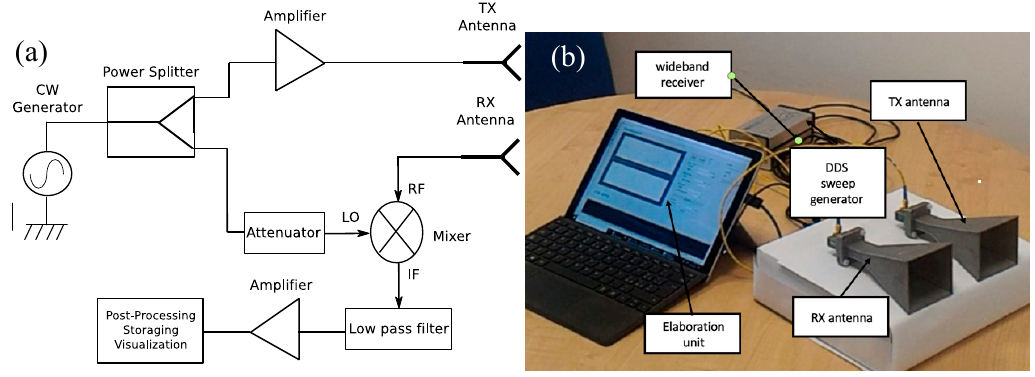
Figure 2 ( a ) Schema of a bistatic reader. ( b ) Photo of a bistatic reader prototype. Figure 2. ( a ) Schema of a bistatic reader. ( b ) Photo of a bistatic reader